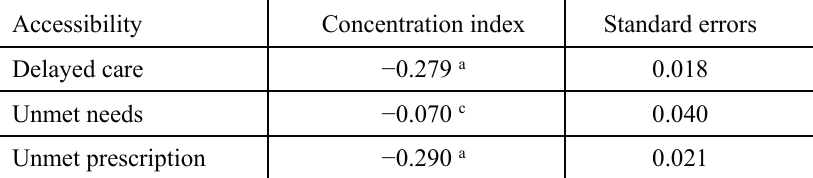
Figure 3. Concentration curves—Access Disparity (Income): Generally perceived delay in healthcare (Delayed care), Generally perceived unmet needed health care (Unmet needs), and Unmet needed prescription drug (Unmet